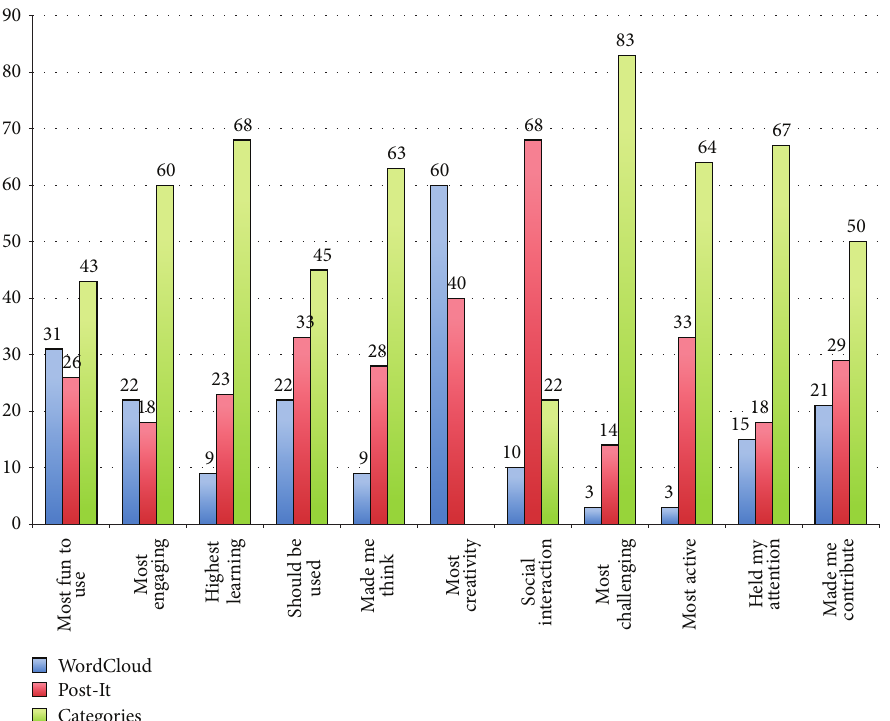
Figure 8: The results of the evaluation of use of applications in lecture two.